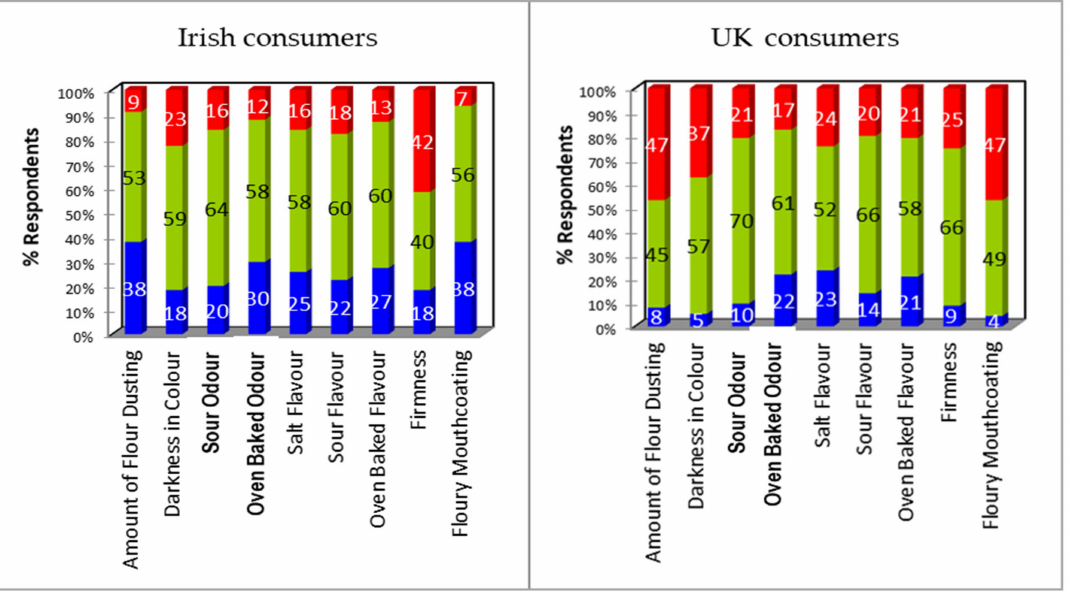
Figure 3. Deviation from ideal / just about right (JAR) for Blaa B from Irish and UK consumers. Data expressed as percent of responses from the collapsed JAR scale in which: Too little (blue) = rating of 1 + 2, Too much (red) = rating of 4 + 5, and Just right (green) = rating of 3.